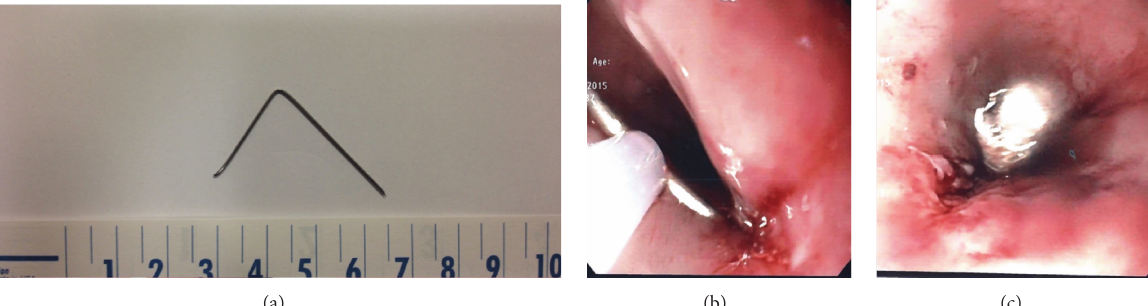
Figure 3: The extracted fractured needle (a). Notice the bent V shape made on the needle with the polypectomy snare and the overtube that permitted the extraction (b). Endoscopic clip on the puncture site (c).